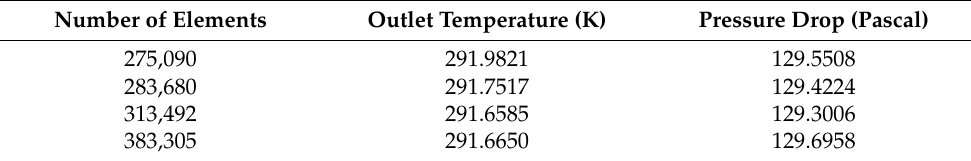
Table 6. Summary of parameters and operating conditions for the